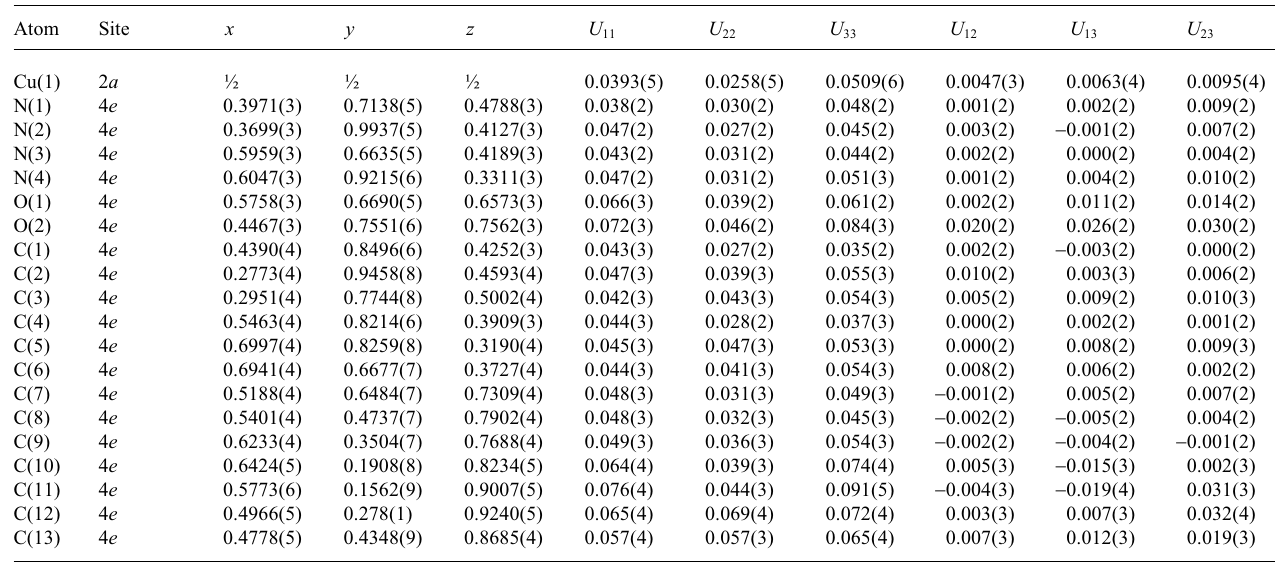
Table 3. Atomic coordinates and displacement parameters (in Å 2 ).